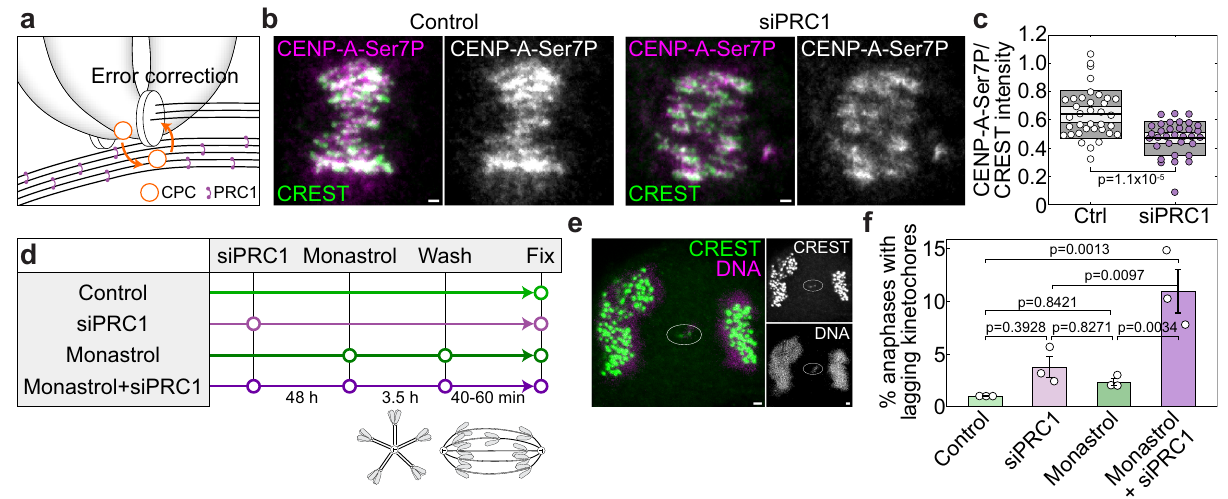
Fig. 6 | PRC1-bound overlap bundles promote chromosome segregation fi de- lity. a Scheme depicting the hypothesis thatantiparallel overlaps help Aurora B to reach the kinetochore components, phosphorylate them and correct erroneous attachments. b Imagesshowinganti-CENP-A-Ser7P(magenta)andCREST(green)in control (left) and PRC1-depletedHeLa cells(right),merged channels and only anti- CENP-A-Ser7Pinwhiteareshown. c Ratiobetweenanti-CENP-A-Ser7PandCRESTin control ( n =36) and PRC1-depleted cells ( n =33), from 3 immunostaining experi- ments. The black line shows the mean; the light and dark gray areas mark 95% con fi denceintervalonthemeanandstandarddeviation,respectively. d Schemeof the protocol in which monastrol washout is used to increases erroneous